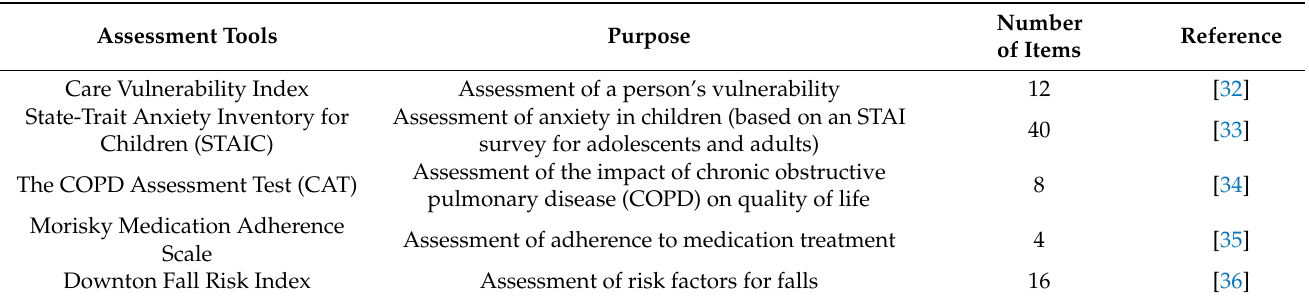
Table 2. Selected assessment tools, purpose and number of